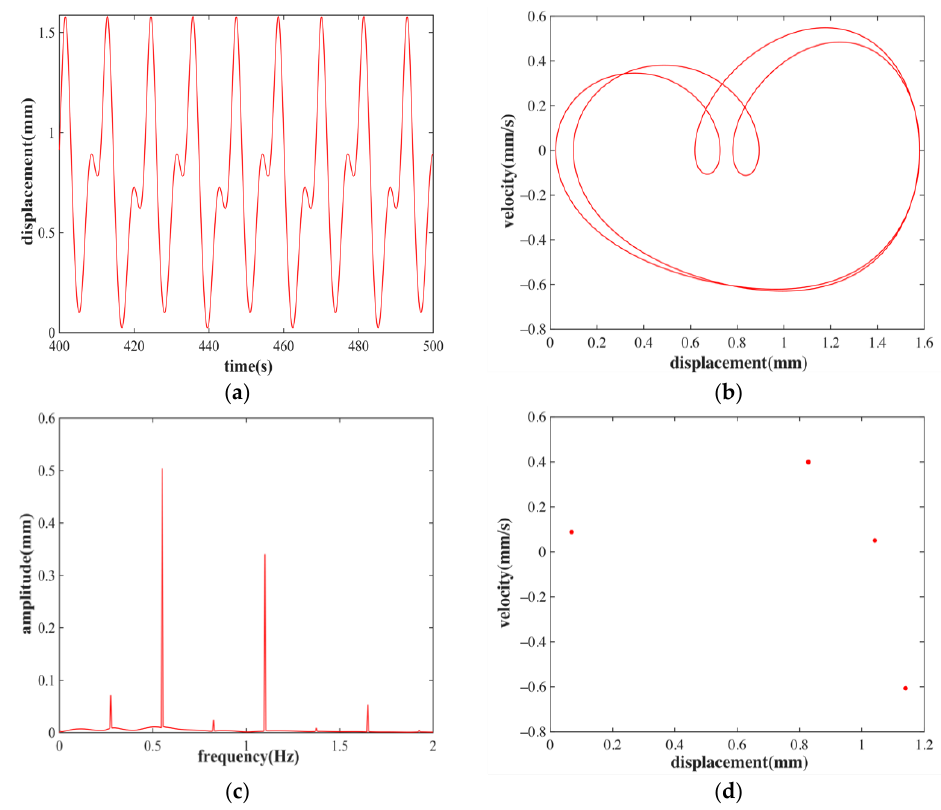
Figure 13. Nonlinear response of the GMA system at α = 0.63: ( a ) Time domain waveform diagram; ( b ) Phase trajectory curve; ( c ) Amplitude spectrum; ( d ) Poincaré diagram.